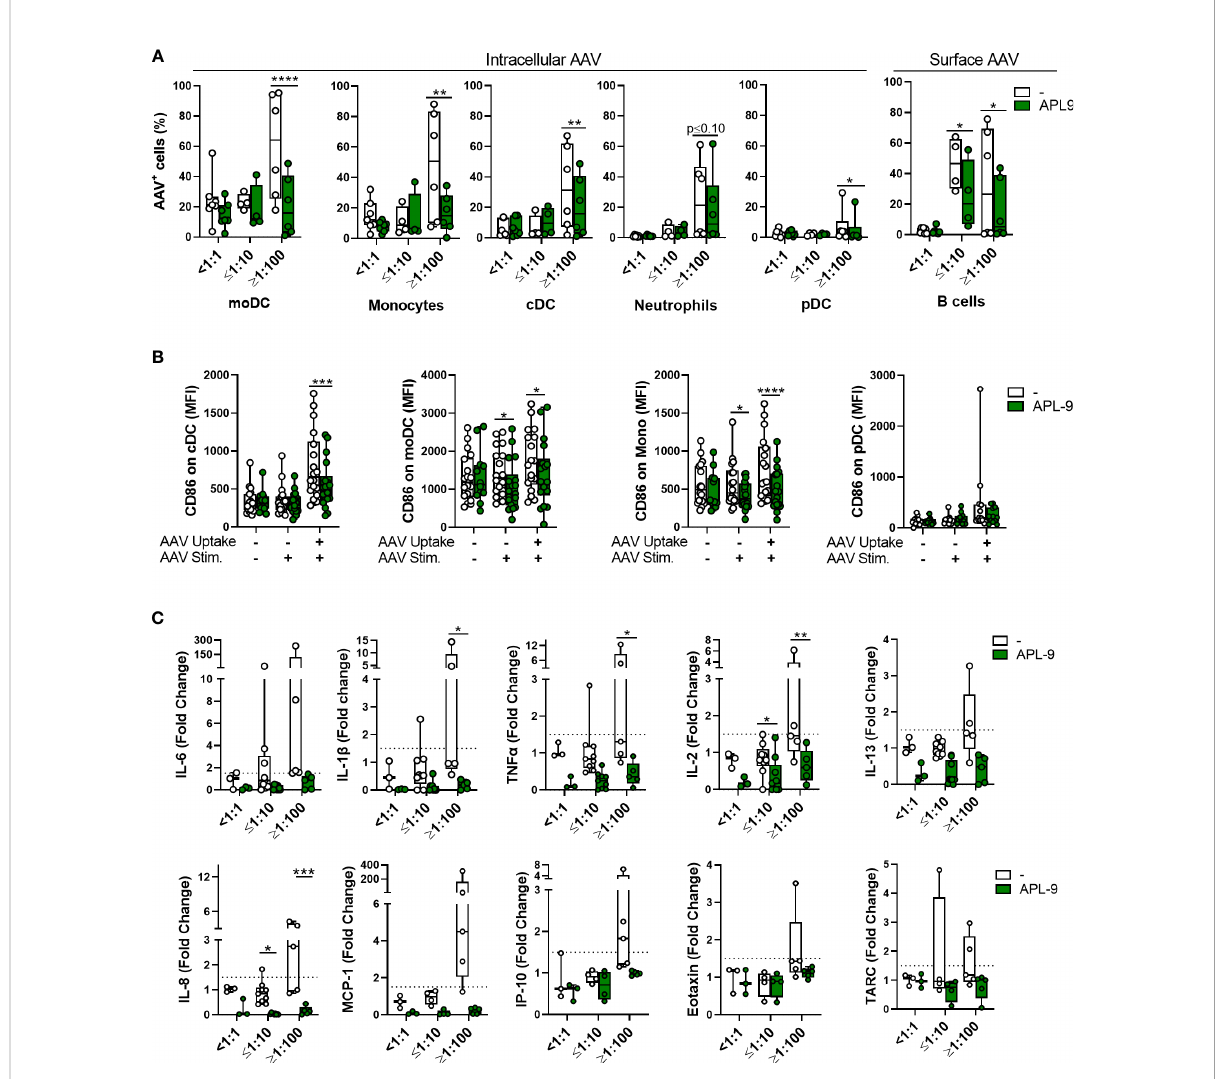
FIGURE 8 C3 complement inhibition lowers innate immune response to AAV in blood. Whole blood from healthy human donors was stimulated with 5×10 11 vg/mL of AAV-LK03 with or without APL-9 for 24 hours and stained for intracellular AAV and phenotypic markers. (A) Percentage of AAV + cells within the indicated cell subtype. Bars represent the mean ± SEM and symbols represent the individual values of blood samples. Signi fi cance was determined with a two-way RM-ANOVA with Sidak ’ s multiple test comparison. (B) Mean fl uorescence intensity (MFI) of CD86 staining for the indicted cell type. Signi fi cance was determined with a mixed effects analysis with Sidak ’ s multiple comparisons test. (C) Cytokine and chemokine secretion from whole blood stimulated with 5×10 11 vg/mL of AAV-Spark100 for 24 hours. Samples were categorized based on their titers of anti-AAV-Spark100 neutralizing antibodies as indicated under x axis. Values for control group are duplicated from Figures 2 – 4. Bars represent mean fold-change ± SEM of each analyte ’ s concentration measured in AAV-stimulated relative to unstimulated blood. Symbols represent the values of each donor. Dashed lines signify a 1.5-fold positivity cutoff. Signi fi cance was determined with a 2way ANOVA with Sidak ’ s multiple comparisons test. *p ≤ 0.05; **p ≤ 0.01; ***p ≤ 0.001; ****p ≤